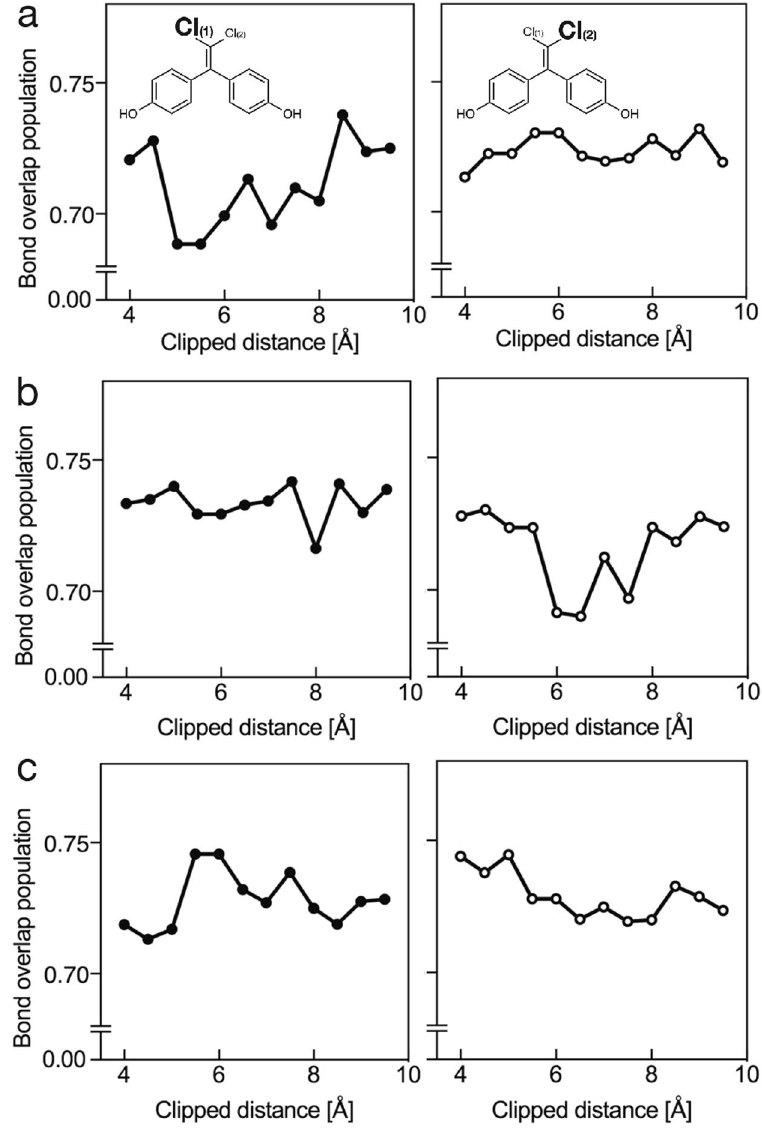
Figure 6. The calculated bond overlap population of chlorine and carbon atoms. The calculated values of bond overlap populations are shown for ( a ) Case 1, ( b ) Case 2, and ( c ) in Case 3 (HIVE chip method). The values of the bond overlap populations converged in Case 3 as upon expansion of the calculated coordinates form the chlorine